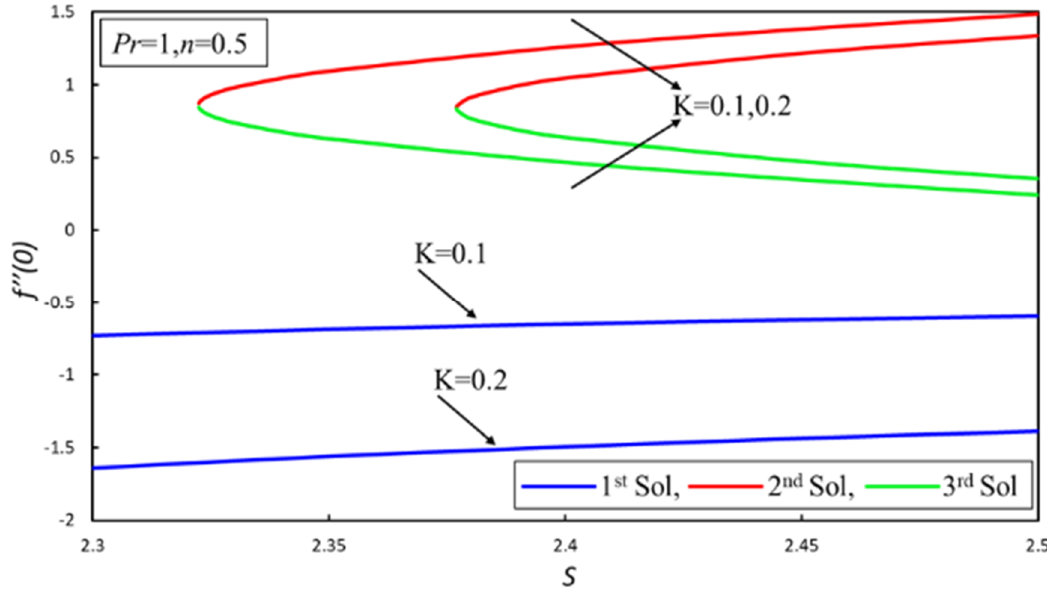
Figure 4. Variation of f (cid:48)(cid:48) ( 0 ) for di ff erent fixed values of K with suction parameter S .